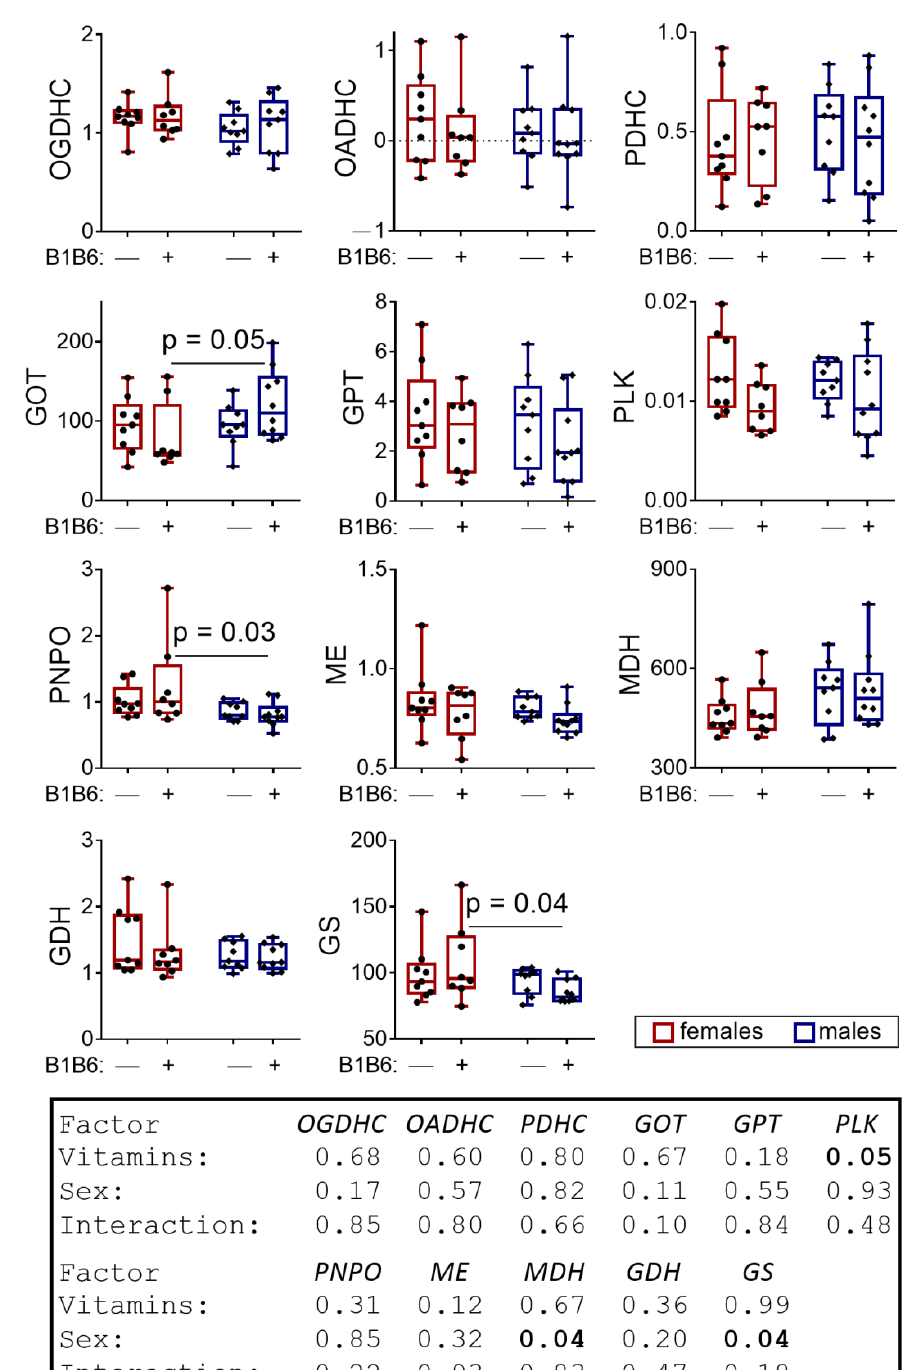
Figure 8. Effects of the administration of vitamins of B1 and B6 to the control rats on the enzymatic activities in the rat brains. The activities are expressed in micromole/min per g of tissue, with the exception for the PNPO activity, expressed in nanomole/min per g of tissue. The statistical analysis of the data was performed by the two-way ANOVA with Tukey ’ s post hoc test (see Section 4).